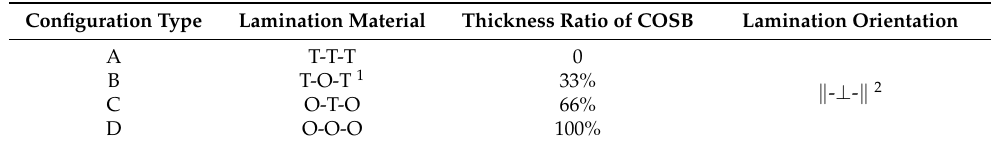
Table 1. CLT and HCLT